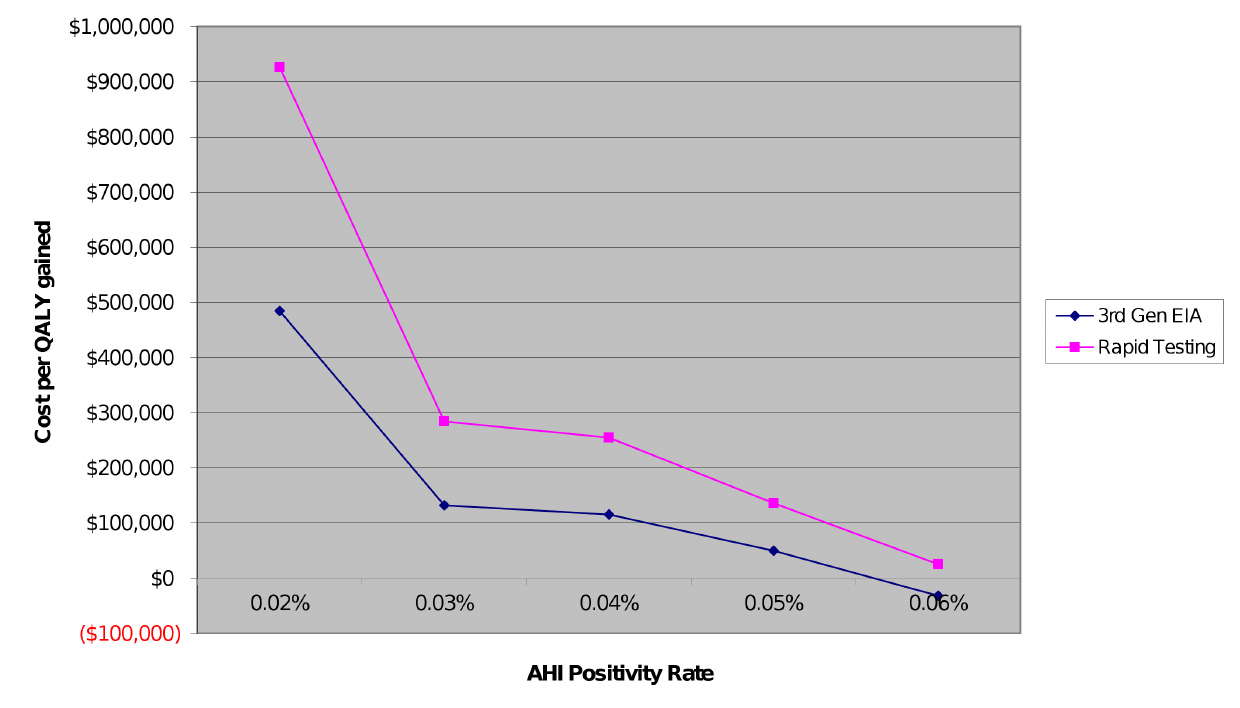
Figure 1. Sensitivity analysis: relationship between AHI positivity rate and cost per QALY gained. Rounded to the nearest tenth of a percentage point. 3 rd -Gen EIA, third-generation enzyme immunoassay.